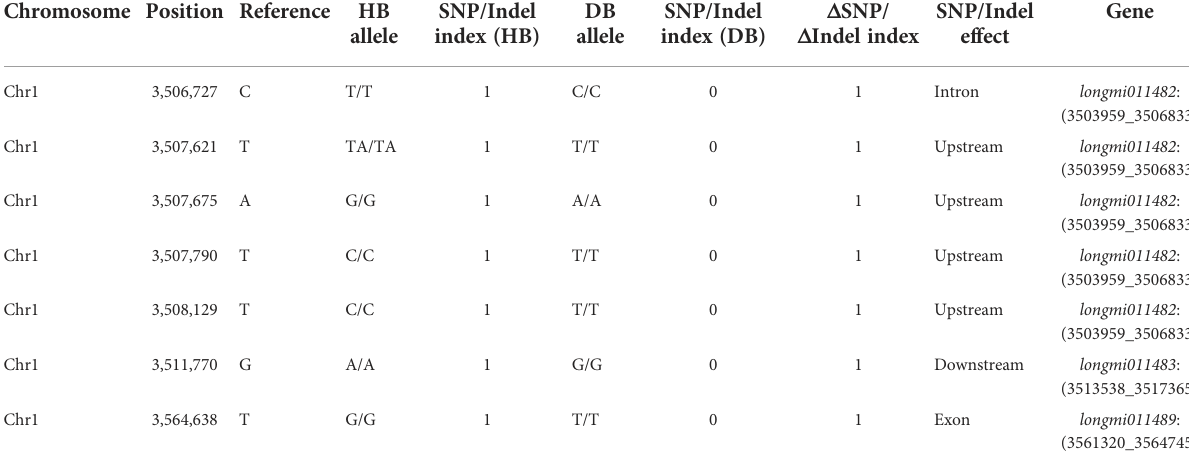
HB, high bulk; DB, dwarf